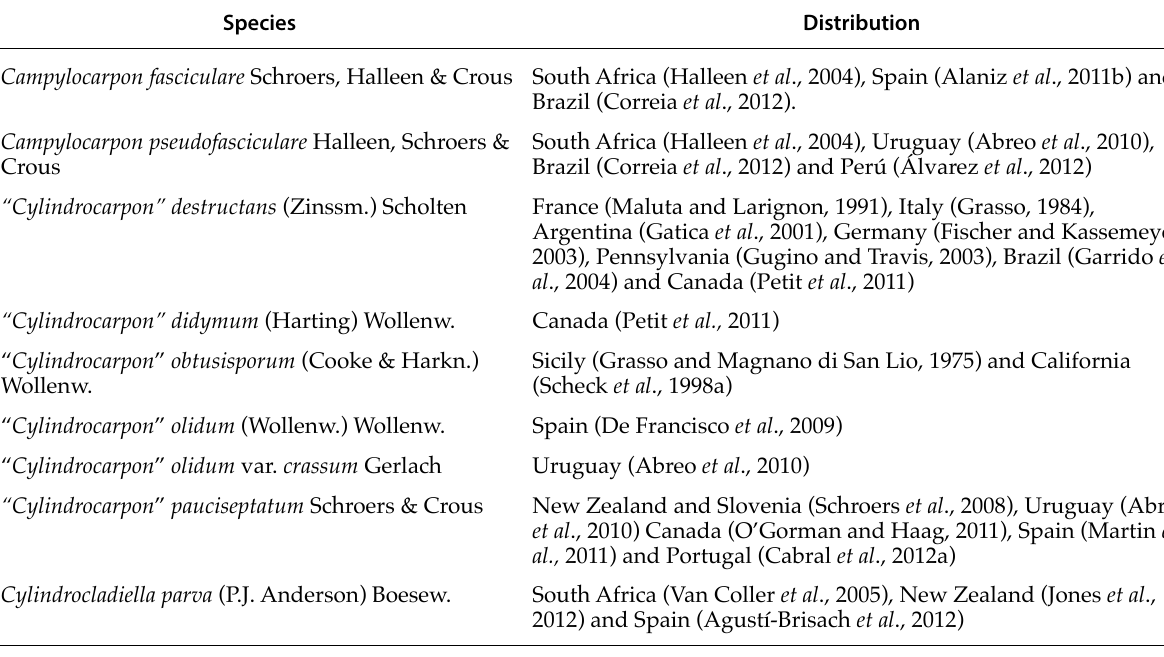
Table 1. Fungal species which have been reported associated with black-foot disease of grapevines and their geographical distribution. Species